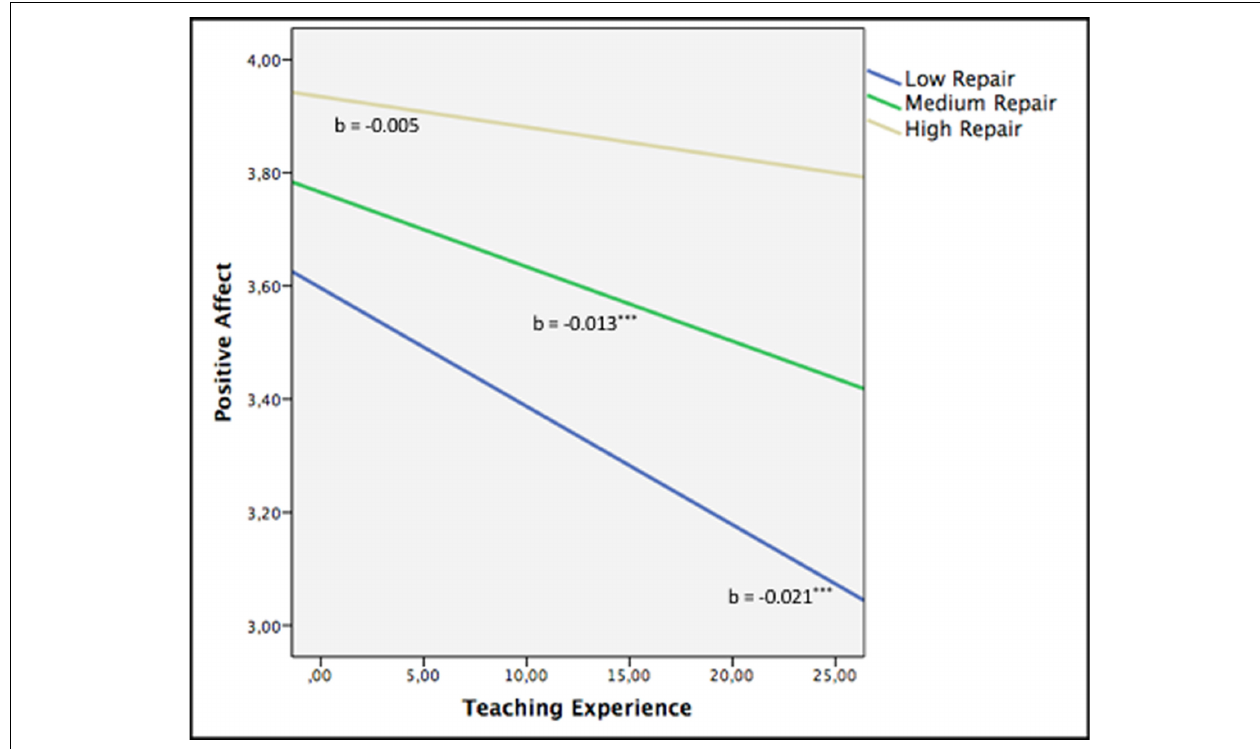
FIGURE 2 | Moderation analysis with Repair as moderator on the association between teaching experience and positive affect. ∗∗∗ p <